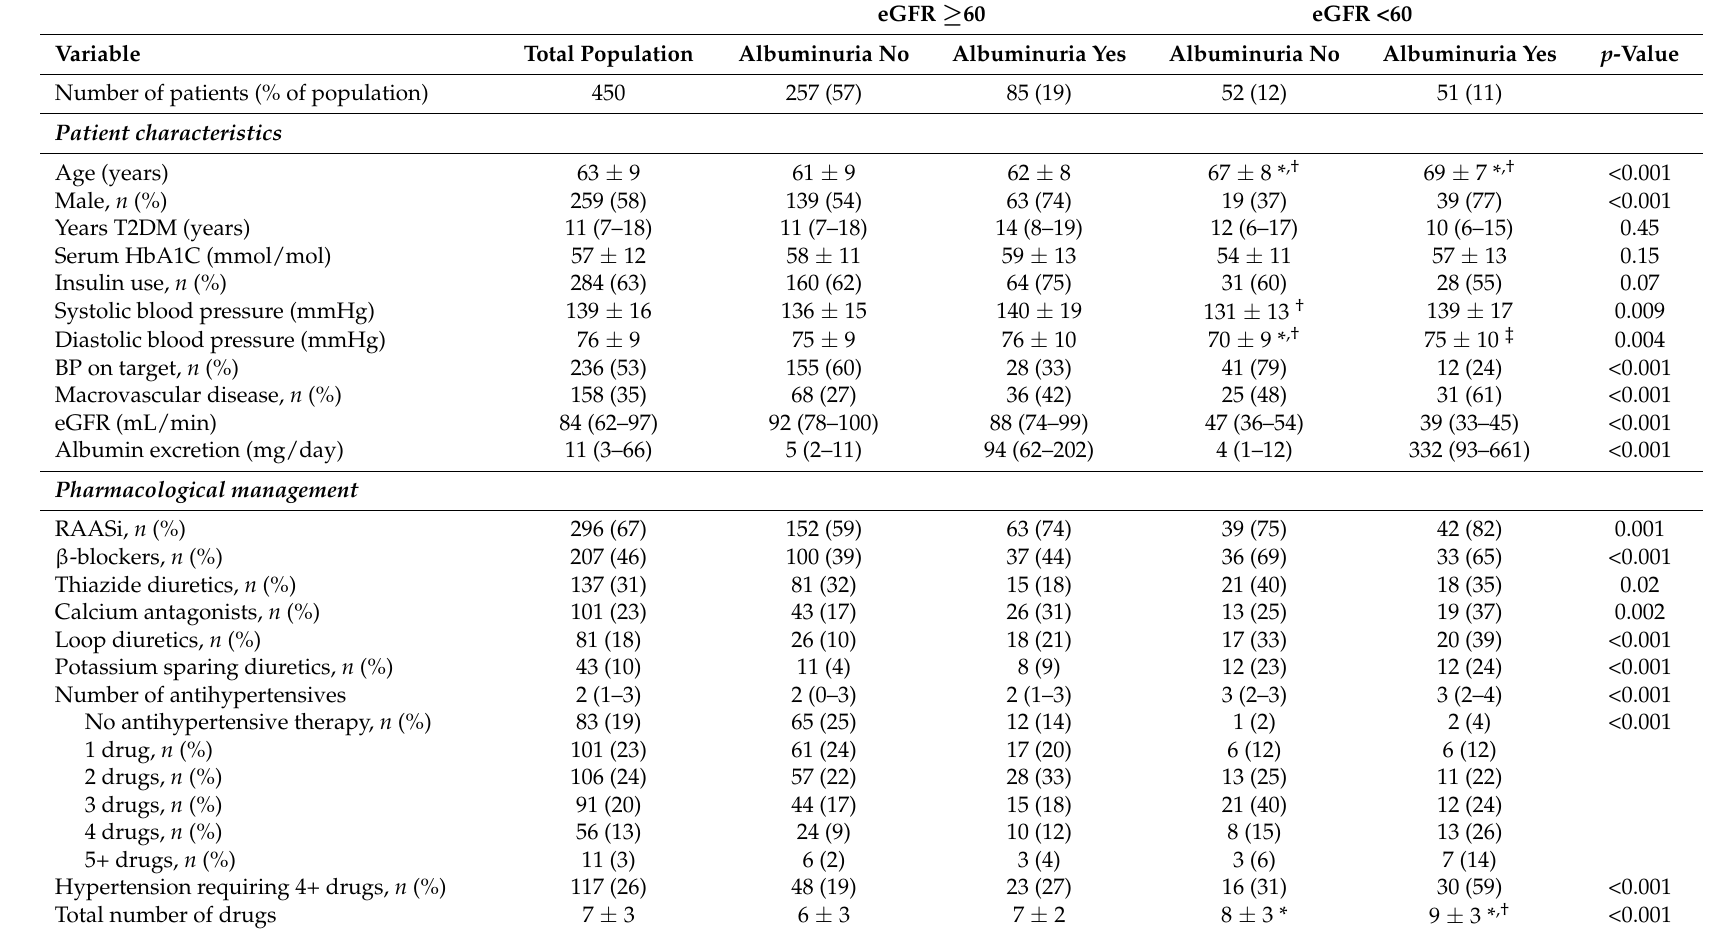
Table 1. DIALECT-1 Baseline, nutritional, and pharmacological